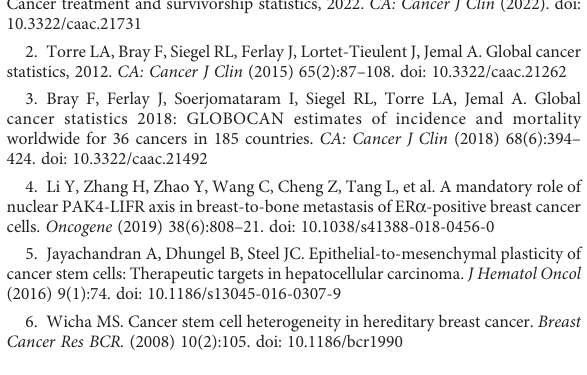
SUPPLEMENTARY FIGURE 1 Heat maps of differential snoRNAs between CD44 + CD24 − subgroup and CD44 − CD24 + subgroup in microarray expression pro fi le. SUPPLEMENTARY FIGURE 2 Positive and negative staining in ISH and IHC. ( A ) negative staining of ISH ( B ) positive staining of ISH ( C ) negative staining of IHC ( D ) positive staining of IHC. Original magni fi cation, 200× (left) and 400× (right). Scale bars, 50 m